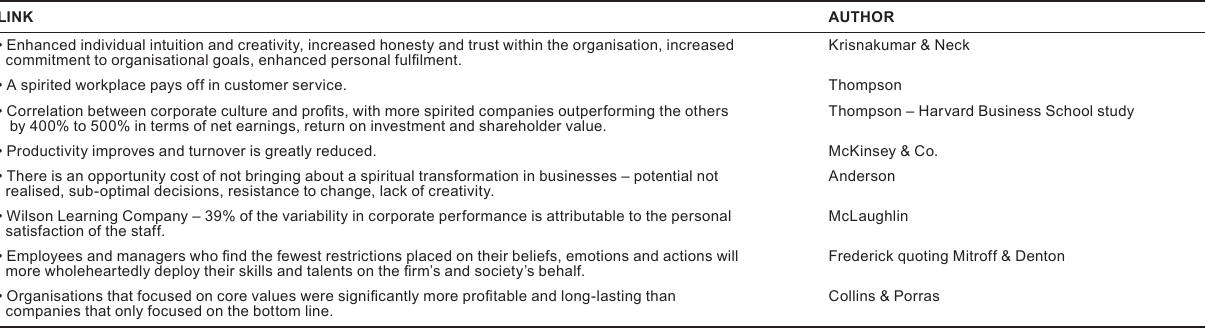
TABLE 1 Evidence of the link between spirituality at work, productivity and profitability